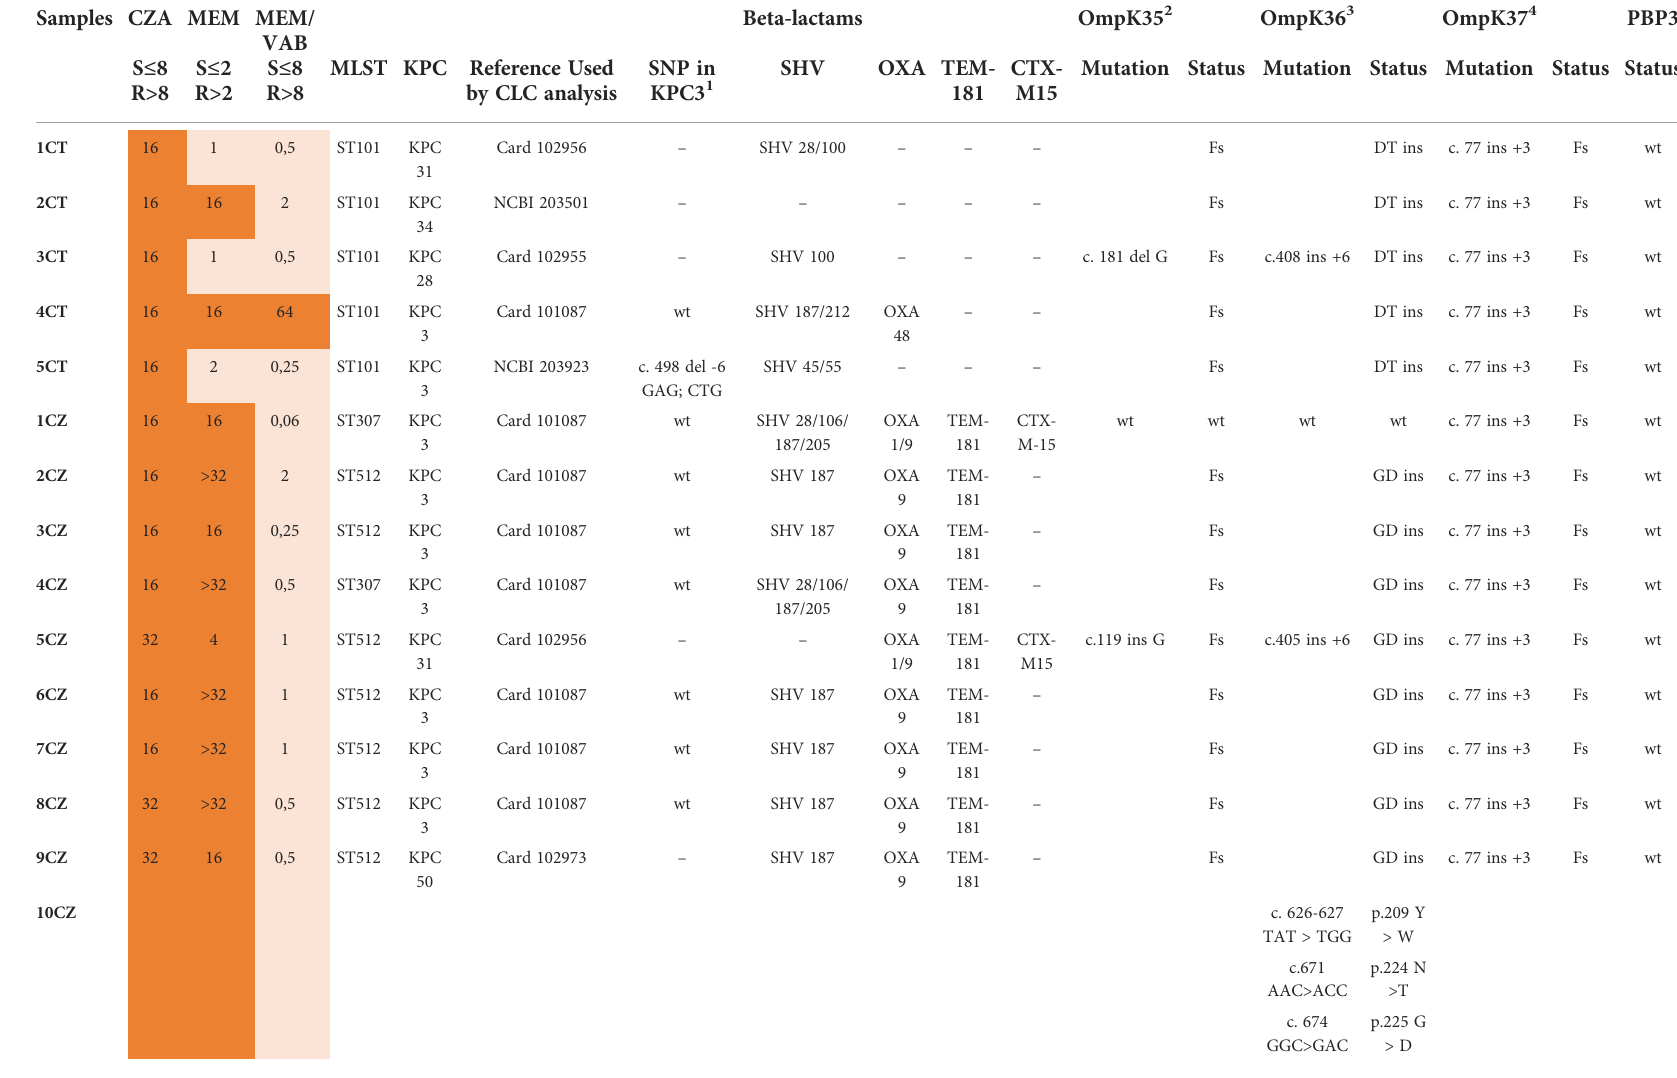
TABLE 3 Phenotype Resistance and Resistome in CZA Resistant K. pneumonia